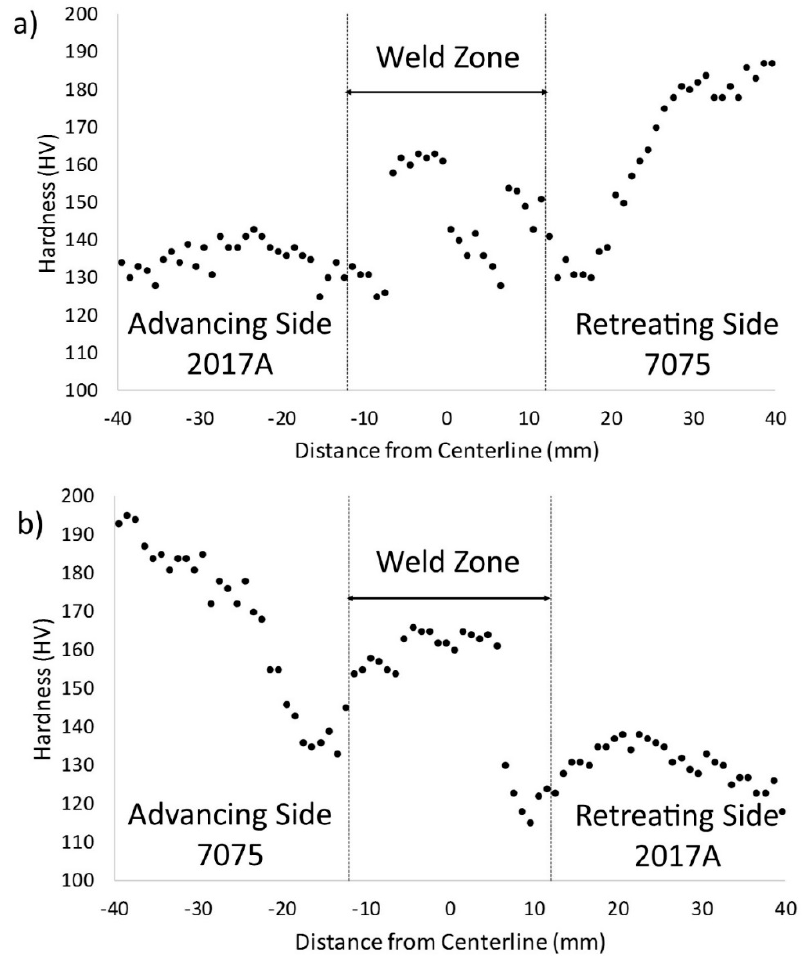
Figure 3. Hardness profiles for: ( a ) AS 2017A/RS 7075 and ( b ) AS 7075/RS 2017A. Profiles reveal the typical W-shape associated with precipitation-hardenable aluminum alloys. Hardness measurement error is ±7.5 HV.